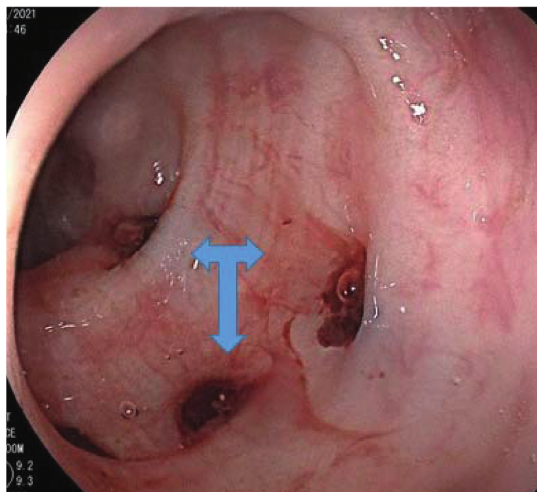
Figure 3: Colonoscopy revealed fresh blood (three-head arrow) in the rectum and sigmoid colon.